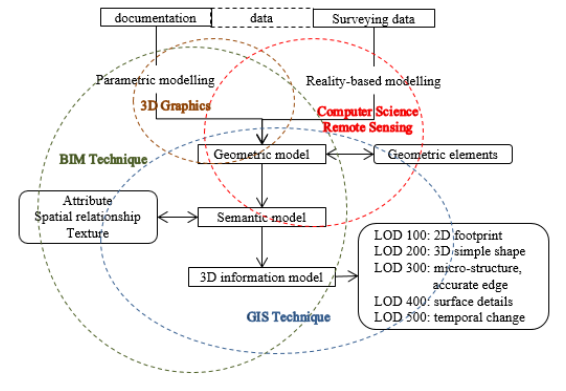
Fig. 1: The overall scheme of enriched heritage modelling with combined